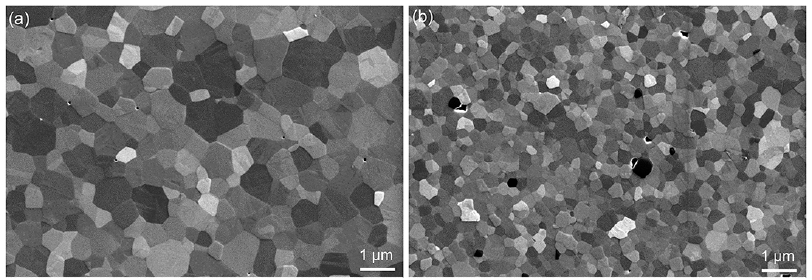
Figure 1. Electron channeling contrast images of the SM- ( a ) and SLA-fabricated ( b ) Y-TZP ceramics (magnification = 10,000×; scale bar = 1 μ m).